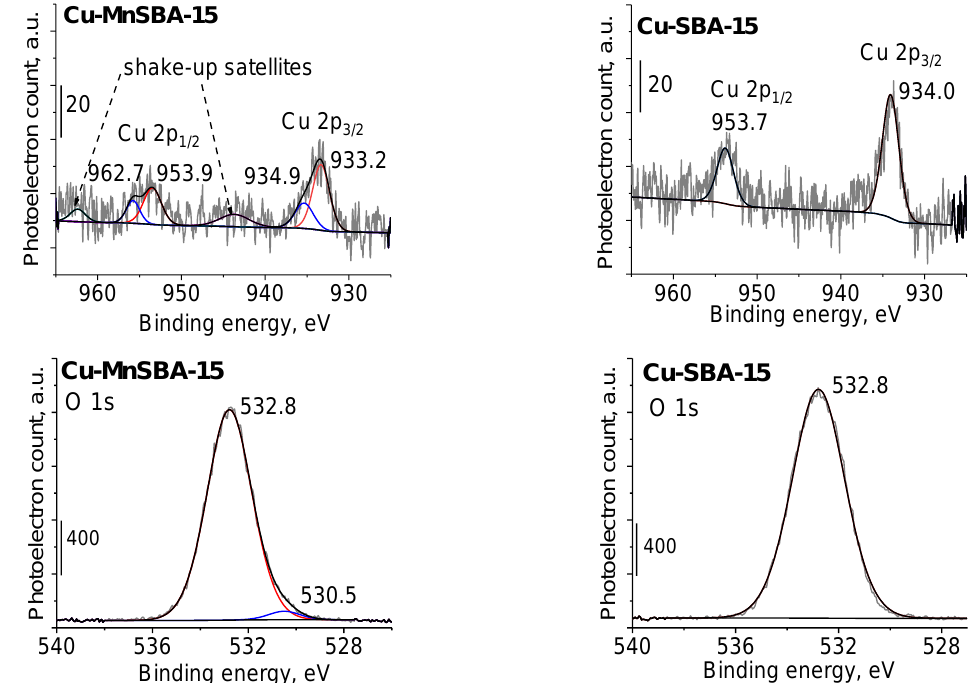
Figure 2. Cu 2p and O 1s regions of XP spectra of copper-containing SBA-15 and MnSBA-15 catalysts. Thus, XPS results showed copper in Cu-SBA-15 to be present as Cu δ + (1 < δ < 2) and/or isolated Cu 2+ whereas in Cu-MnSBA-15 copper is present in both oxidation states Cu δ + (1 < δ < 2) and Cu 2+ in copper oxide(II). The change in BE of copper species in